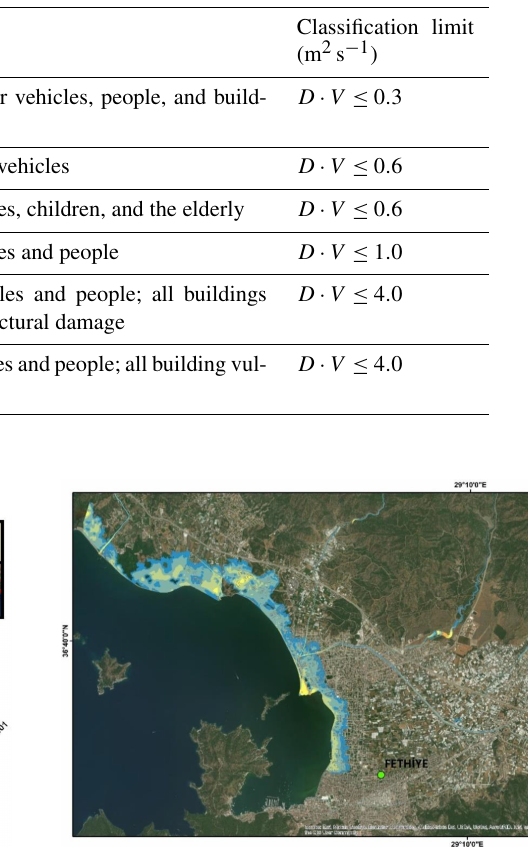
Figure 10. Inundation due to flood hazards considered in the study (sources: Esri, Maxar, GeoEye, Earthstar Geographics, CNES/Air- bus DS, USDA, USGS, AeroGRID, IGN, and the GIS User Com- munity).